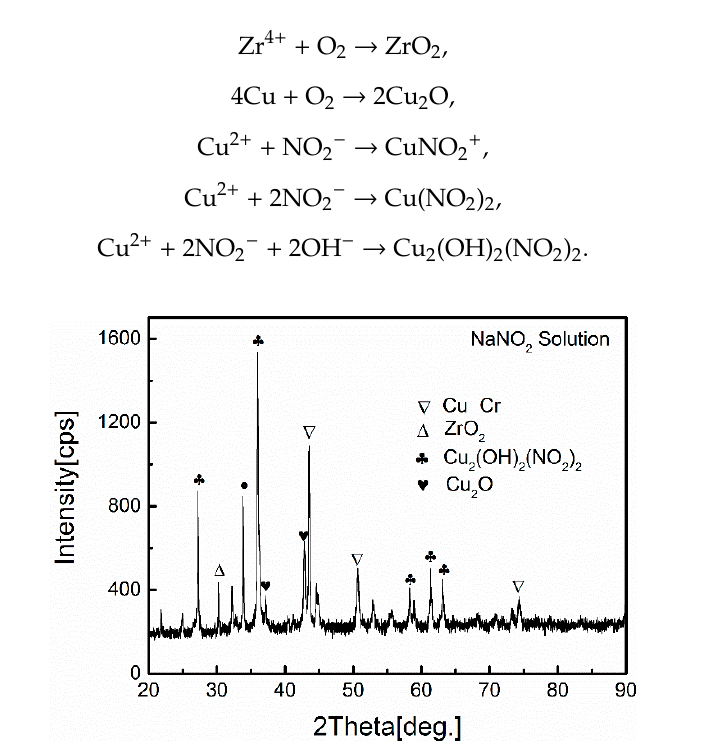
Figure 5. X-ray diffraction (XRD) analysis map of corrosion product film in NaNO 2 solution. Figure 5. X-ray di ff raction (XRD) analysis map of corrosion product film in NaNO 2